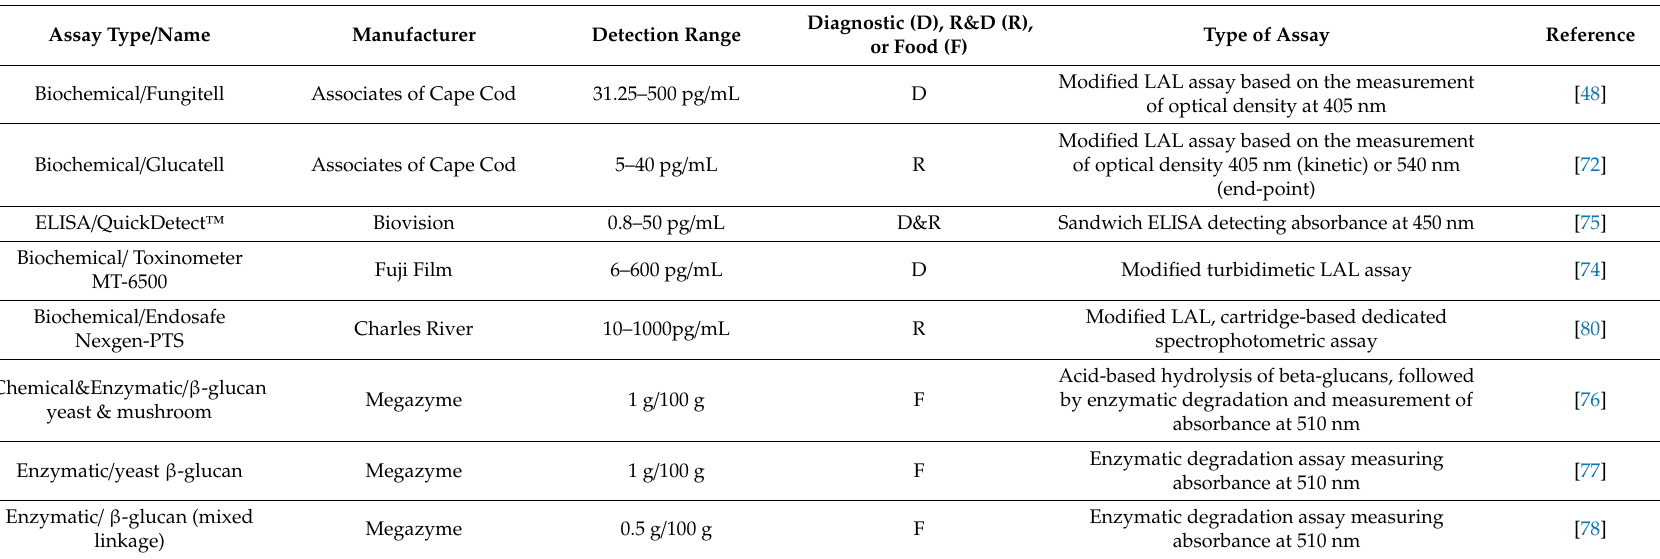
Table 3. Assays for detection of beta-glucans in biological matrices and test-materials. LAL = Limulus amoebocyte lysate